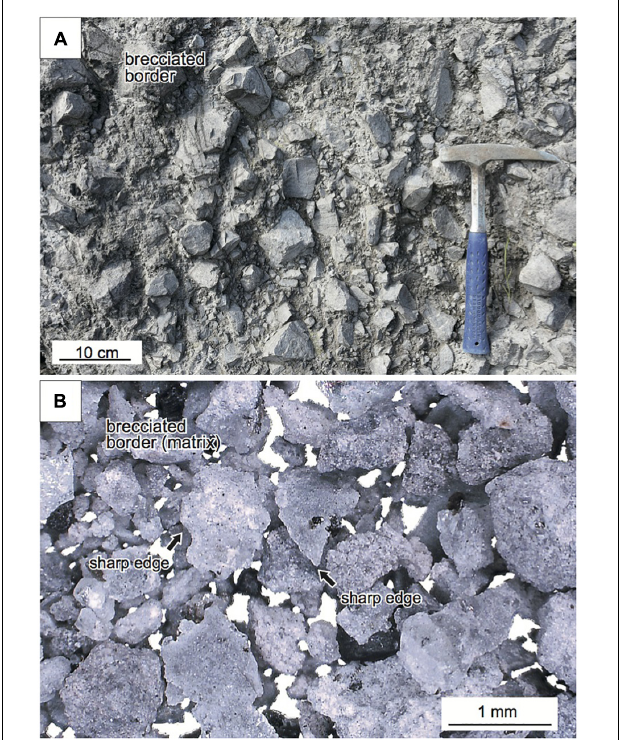
FIGURE 7 | (A) Photograph of the brecciated border of the Ogariyama dome, which comprises monolithological breccia consisting of angular rhyodacite clasts and a cogenetic matrix. (B) Close-up view of rhyodacite fragments in the matrix of the brecciated border. Some rhyodacite fragments have a flaky morphology with sharp edges (solid arrows). The photograph was taken with a digital